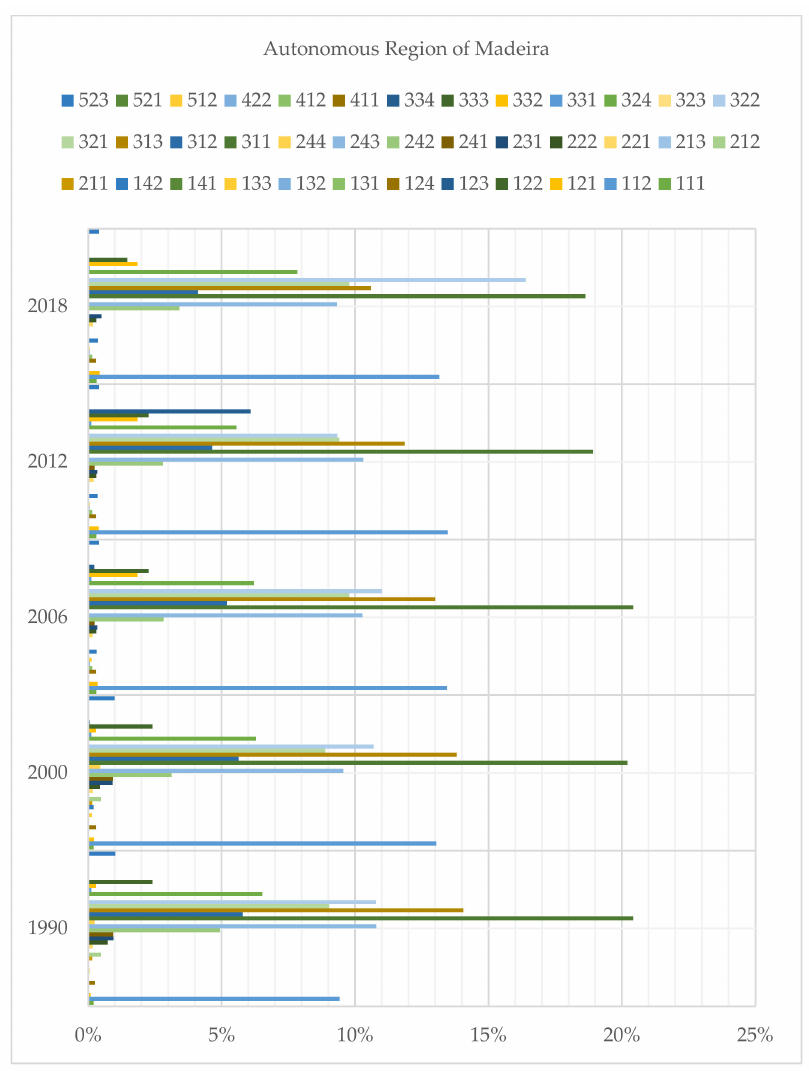
Figure 10. Percentage of land-uses according to CLC nomenclature in the Autonomous Region of